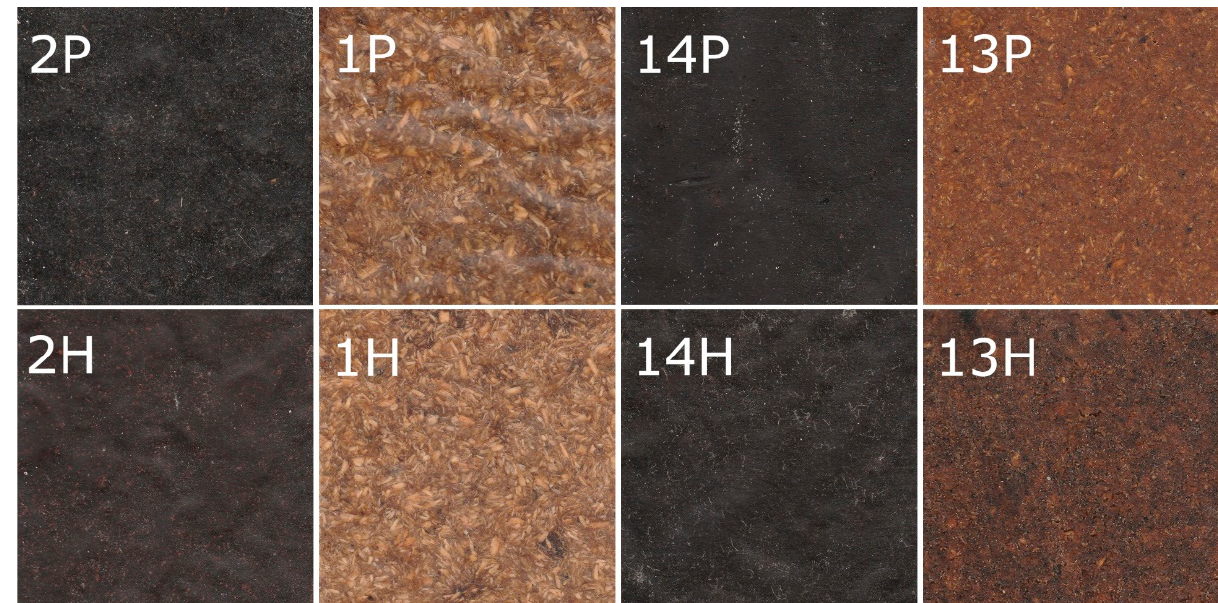
Figure 1. Examples of PLA- and HDPE-based composites. Table 1. PLA-based composites characteristics.